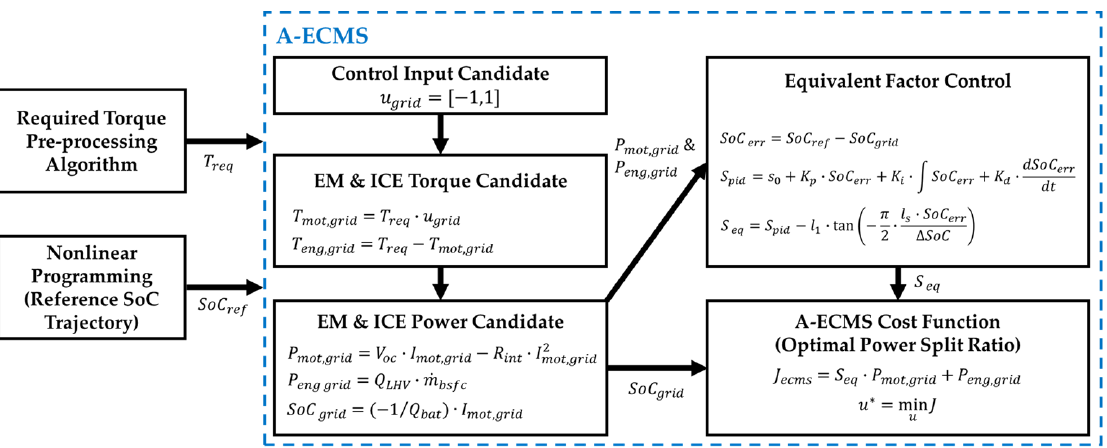
Figure 7. Conceptual diagram of A-ECMS in NLP-ECMS.